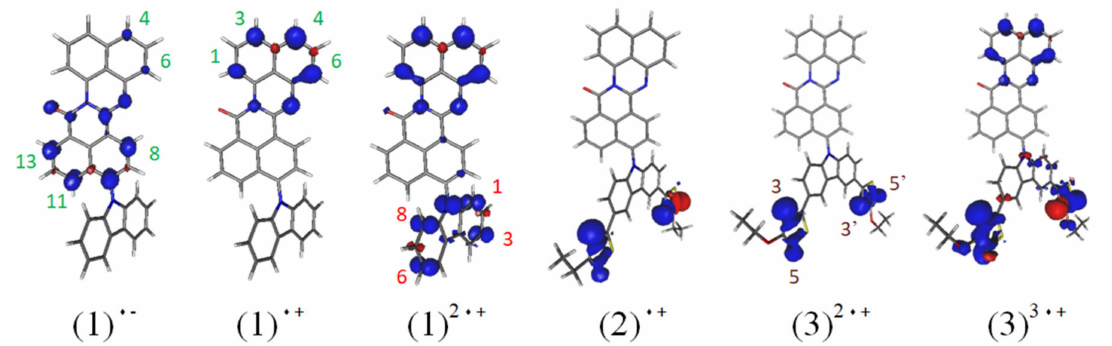
Figure 1. Spin density located at positions of carbazole ( red ), thiophenes ( brown ) and 14H-benz[4,5]isoquino[2,1-a]perimidin- 14-one unit ( green ) of selected oxidized and reduced states of 1–3 moieties—calculated at B3LYP/6-31G(d)/CPCM(DCM), isovalue equal to 0.005 e − /au 3 in each case.